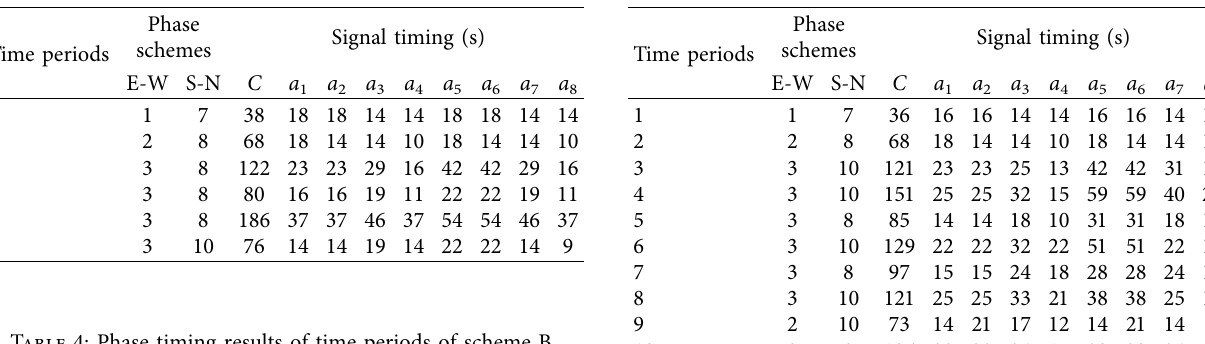
Table 4: Phase timing results of time periods of scheme B. Time periods